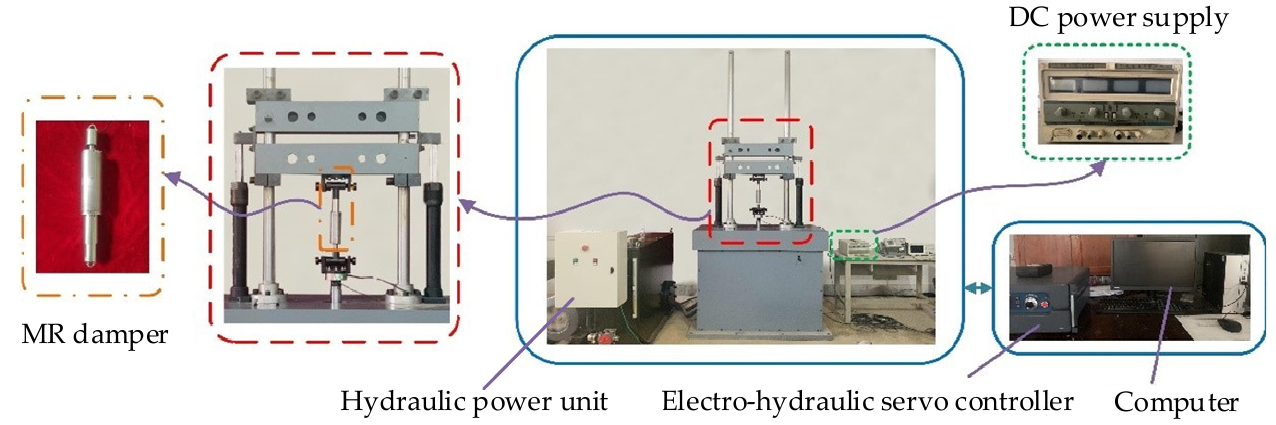
Figure 1. Vibration test system of MR damper.